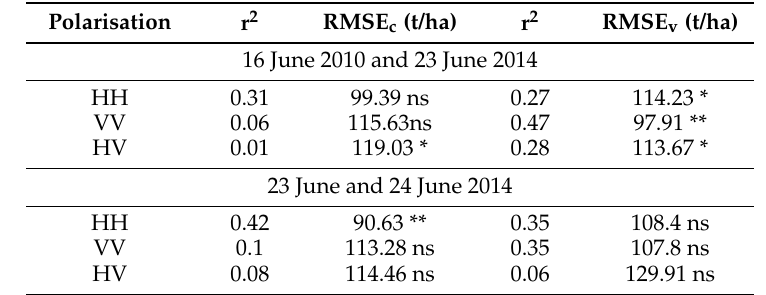
Table 9. Results of biomass regression models using S-band backscattering ( σ ˝ ) in Savernake and Wytham at 0.25 ha resolution. r 2 is the coefficient of correlation and RMSE c is the root mean square error calculated using cross-validation of the training plots (25 stands) for 2010 and 2014 in Savernake Forest and Wytham Woods. RMSE v is the error when applying the regression model to the validation plots (16 stands in Savernake Forest).